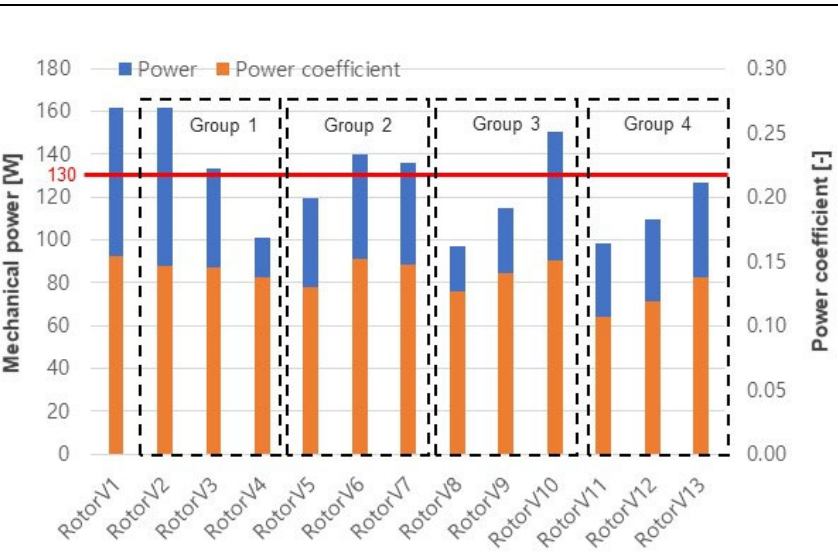
Figure 6. Rotor power and efficiency according to semi ‐ circular rotor design parameters.